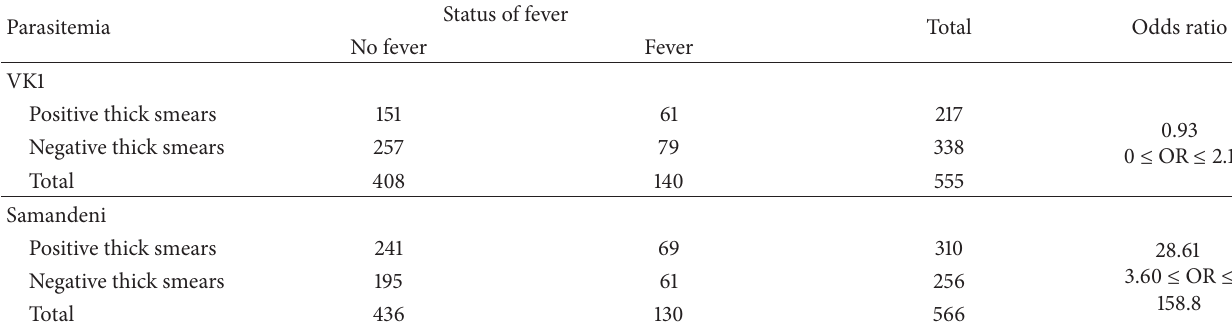
Table 2: Relation between presence of fever and malaria-carrying